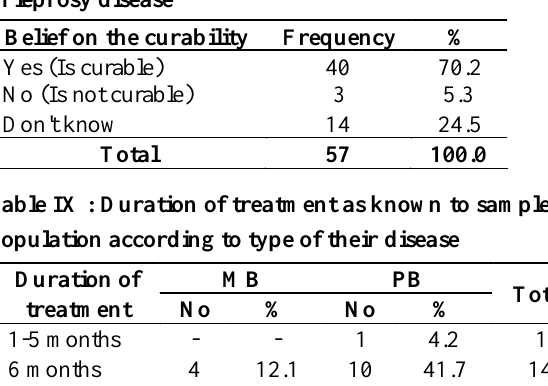
Table VIII : Belief of sample population on the curability